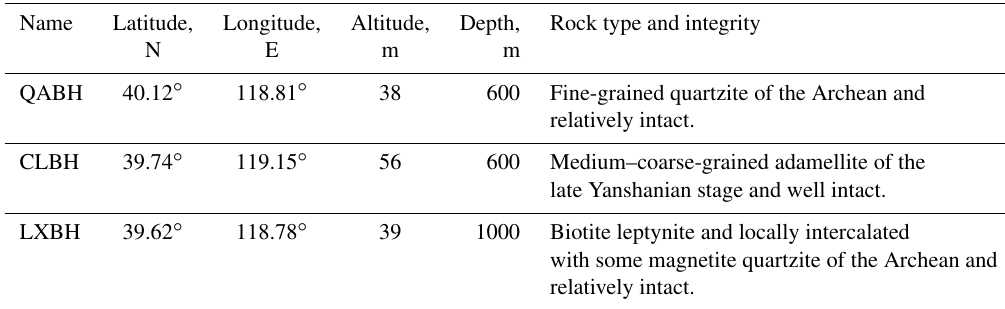
Table 1. General conditions of three in situ stress boreholes measured in the Tangshan seismic region. Name Latitude, Longitude, Altitude, Depth, Rock type and integrity N E m m QABH 40.12 ◦ 118.81 ◦ 38 600 Fine-grained quartzite of the Archean and relatively intact. 119.15 ◦ 56 600 Medium–coarse-grained adamellite of the late Yanshanian stage and well intact.